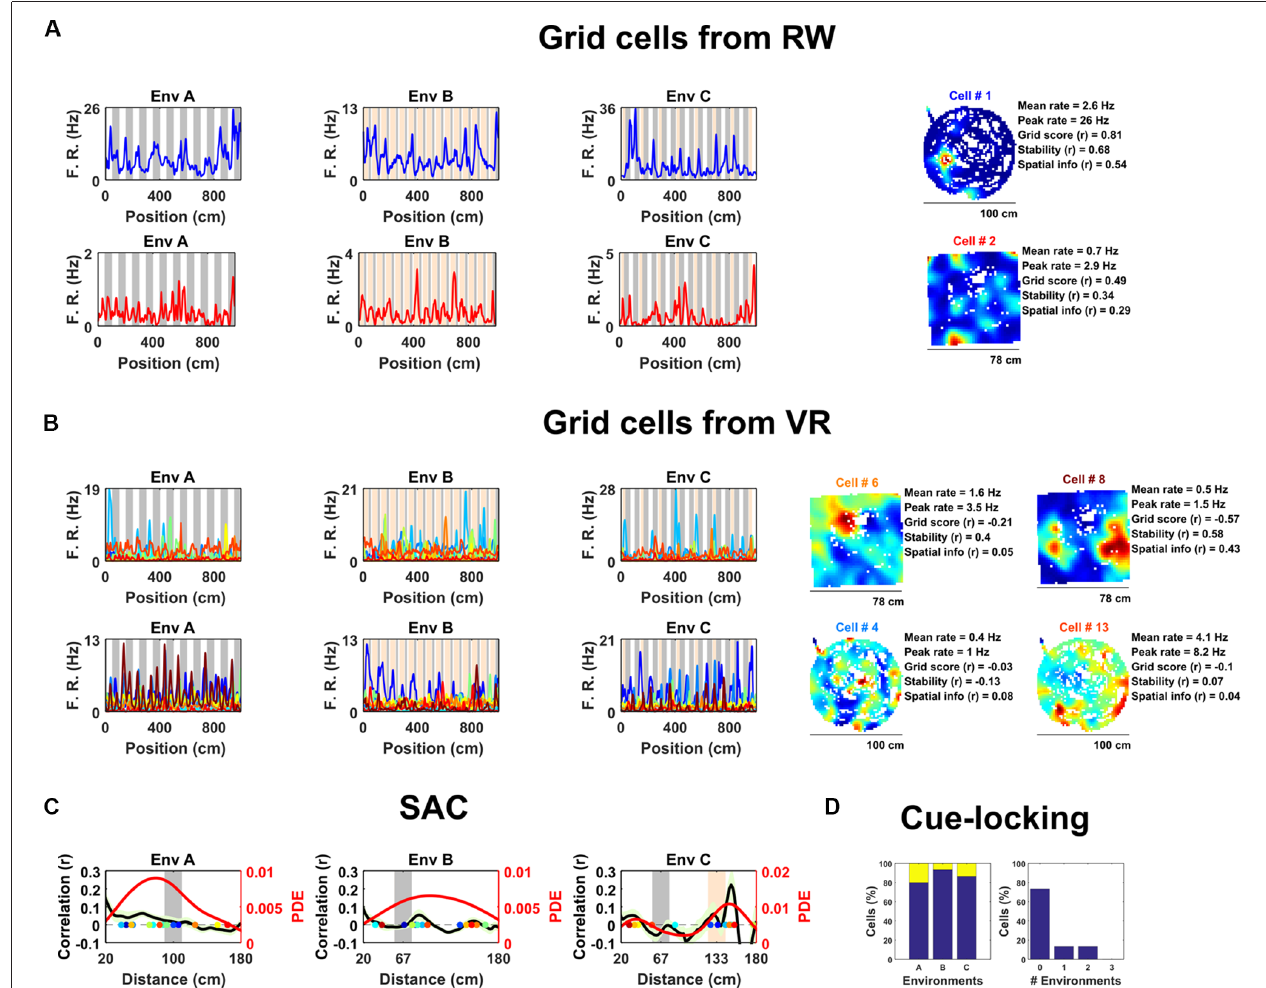
FIGURE 1 | Spatially periodic activity in real world (RW) and virtual reality (VR) environments, a subset of non-grid medial entorhinal (mEC) cells show cue-locking in VR environments. (A) Spatial activity from two example grid cells—identified based on RW recordings ( right )—in each of the three VR environment ( left ). Repeating cues are indicated as colored bars in the background of the VR plots. Cells are color coded such that the title on RW ratemaps matches line color on the VR plots. (B) Similar to (A) , spatial activity from two cells which were (incorrectly) classified as grids cells based on VR activity ( left ) but not based on RW open field activity ( right ). Despite the regularity of their firing patterns in VR, these cells showed no clear grid-like firing in RW and only limited spatial responses. (C) Cue-locking in grid cells ( n = 15, identified from RW) was investigated using spatial auto-correlograms (SACs). Plots show mean (black line) ± SEM (light green shade area) SACs across cells (left y -axis). Note the lack of periodicity corresponding to the frequency of cues in the VR environments (indicated by gray and orange bands). The overlaid color-coded dots represent the dominant spatial frequency in the 20–180 cm range detected from the SAC of each grid cell—the distribution of these points is indicated by the red line (right y -axis). (D) Proportion of grid cells exhibiting cue-locking (yellow) and no cue-locking (blue) in each VR environment ( left ) and proportion showing cue-locking in multiple VR environments ( right ).